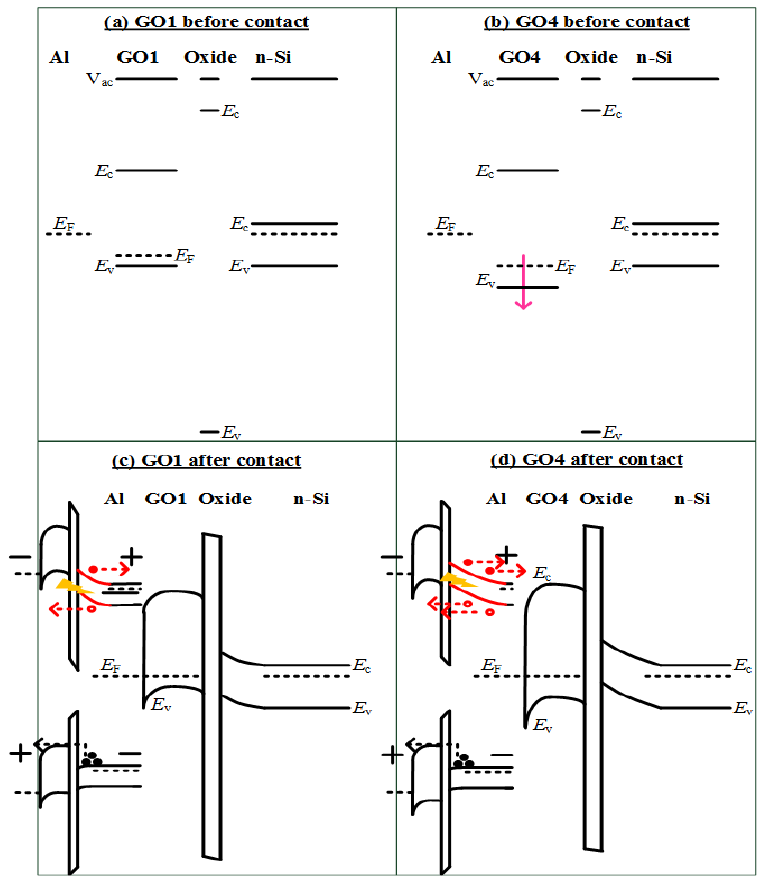
Figure 8. Band diagrams for ( a ) GO1 and ( b ) GO4 detectors on n-Si before and ( c ) GO1 and ( d ) GO4 detectors after contact. At the inversion bias (upper inset of ( c , d )), the larger work function of GO4 contributed to a wider depletion region in the n-Si. At the accumulation bias (lower inset of ( c , d )), the component of “electrons from Si to the Al gate” would predominate over the component of “holes from the Al gate to Si” due to the smaller SiO 2 oxide barrier.